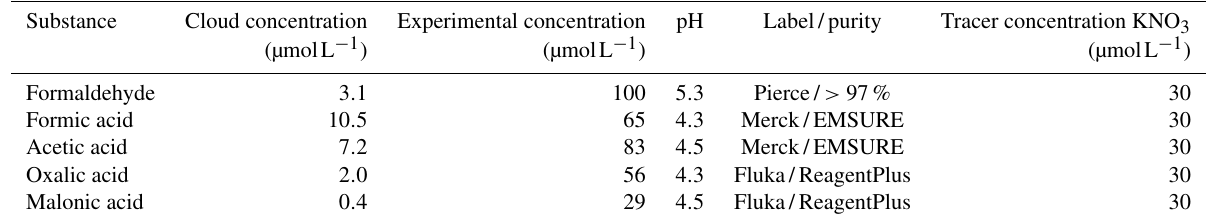
Table 2. Liquid-phase concentrations of the investigated substances and corresponding pH. Ambient cloud water concentrations are means of three events (van Pinxteren et al., 2005). The presence of CO 2 ( ≈ 400µmolmol − 1 ) was neglected in the pH calculation except for HCHO. Substance Cloud concentration Experimental concentration pH Label/purity Tracer concentration KNO 3 (µmolL − 1 ) (µmolL − 1 ) (µmolL − 1 ) Formaldehyde 3 . 1 100 5 . 3 Pierce/ > 97% 30 Formic acid 10 . 5 65 4 . 3 Merck/EMSURE 30 Acetic acid 7 . 2 83 4 . 5 Merck/EMSURE 30 Oxalic acid 2 . 0 56 4 . 3 Fluka/ReagentPlus 30 Malonic acid 0 . 4 29 4 . 5 Fluka/ReagentPlus